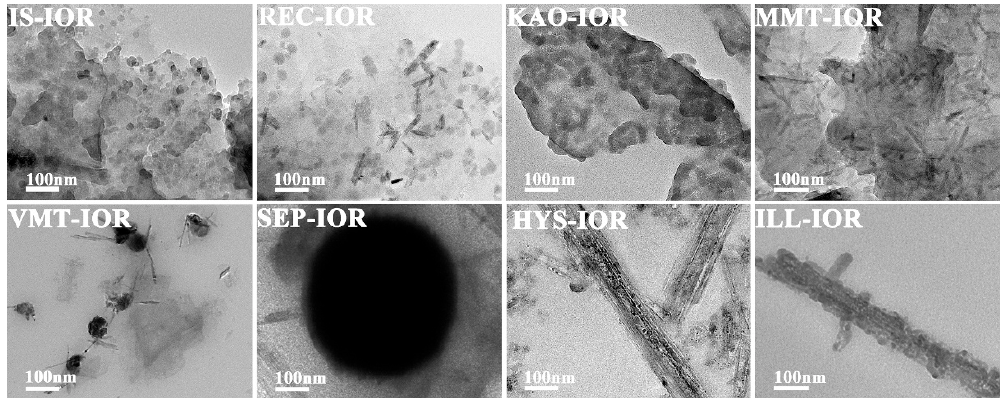
Figure 4. TEM images of IS-IOR, REC-IOR, KAO-IOR, MMT-IOR, VMT-IOR, SEP-IOR, HYS-IOR, and ILL-IOR.